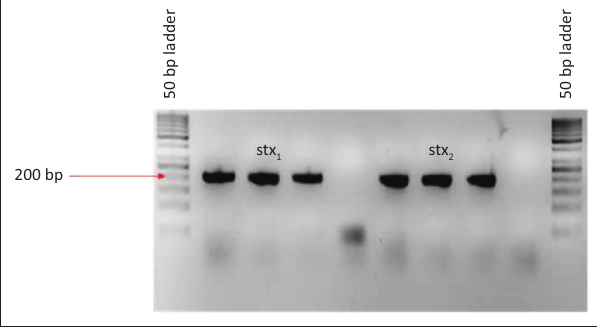
FIGURE 2: Polymerase chain reaction amplicons of stx